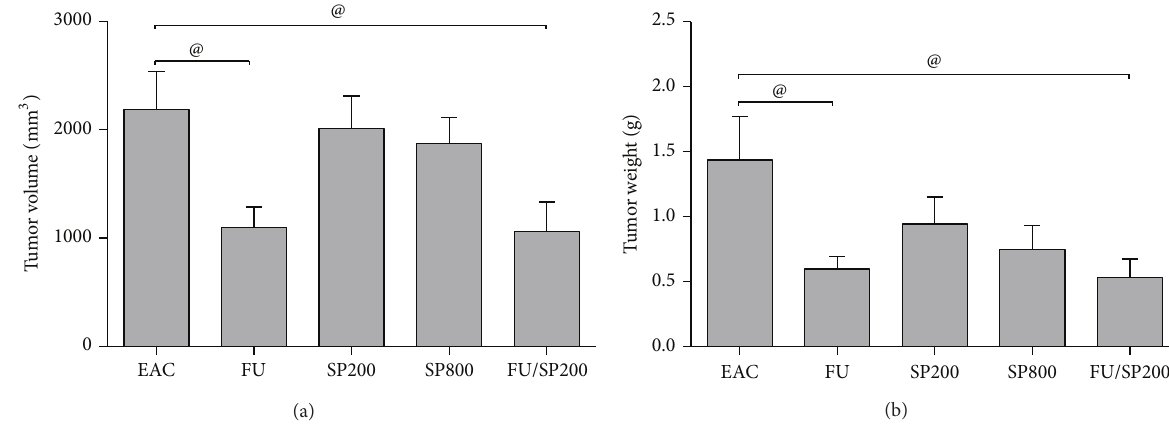
Figure 1: Effect of 5-fluorouracil (20 mg/kg), spirulina (200 or 800 mg/kg), and their combination on tumor volume (a) and tumor weight (b) of EAC tumor-bearing mice ( 𝑛 = 5–9). EAC: Ehrlich ascites carcinoma tumor-bearing mice; FU: Ehrlich ascites carcinoma tumor-bearing mice treated with 5-fluorouracil (20mg/kg); SP200: Ehrlich ascites carcinoma tumor-bearing mice treated with spirulina (200mg/kg); SP800: Ehrlich ascites carcinoma tumor-bearing mice treated with spirulina (800mg/kg); FU/SP200: Ehrlich ascites carcinoma tumor-bearing mice treated with 5-fluorouracil (20 mg/kg) plus spirulina (200mg/kg). Data are expressed as mean ± SEM. Statistical analysis using one-way ANOVA, followed by Dunnett’s posttest. @ 𝑃 < 0.05 versus EAC group.